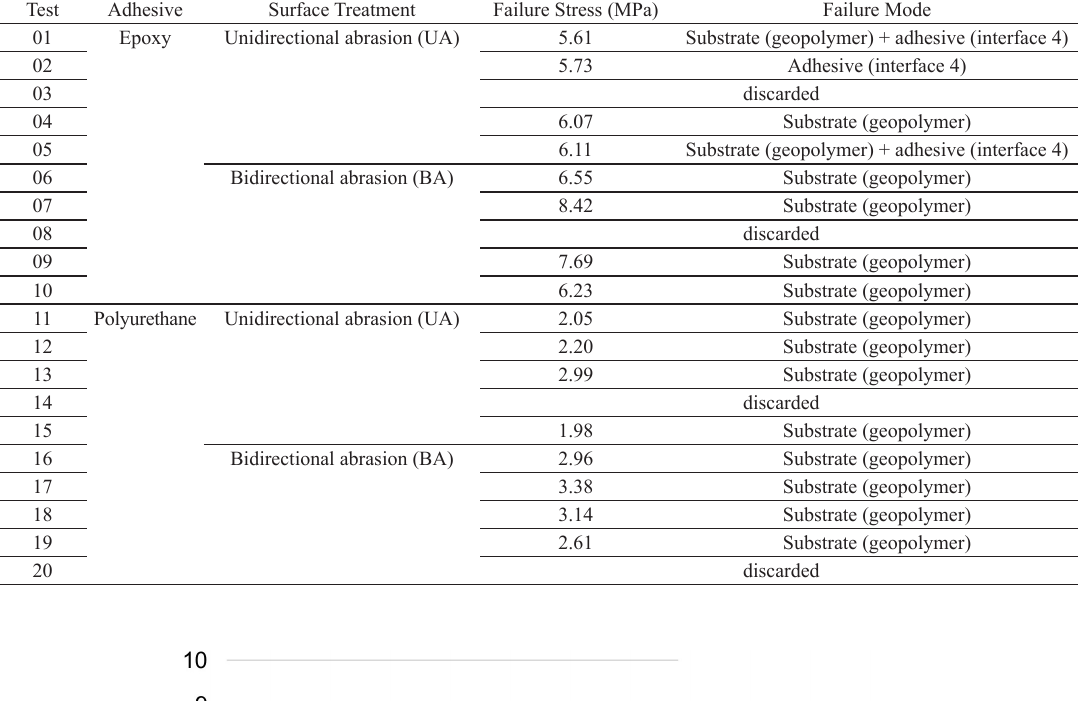
Table 4. Average strength of the pull off tests.